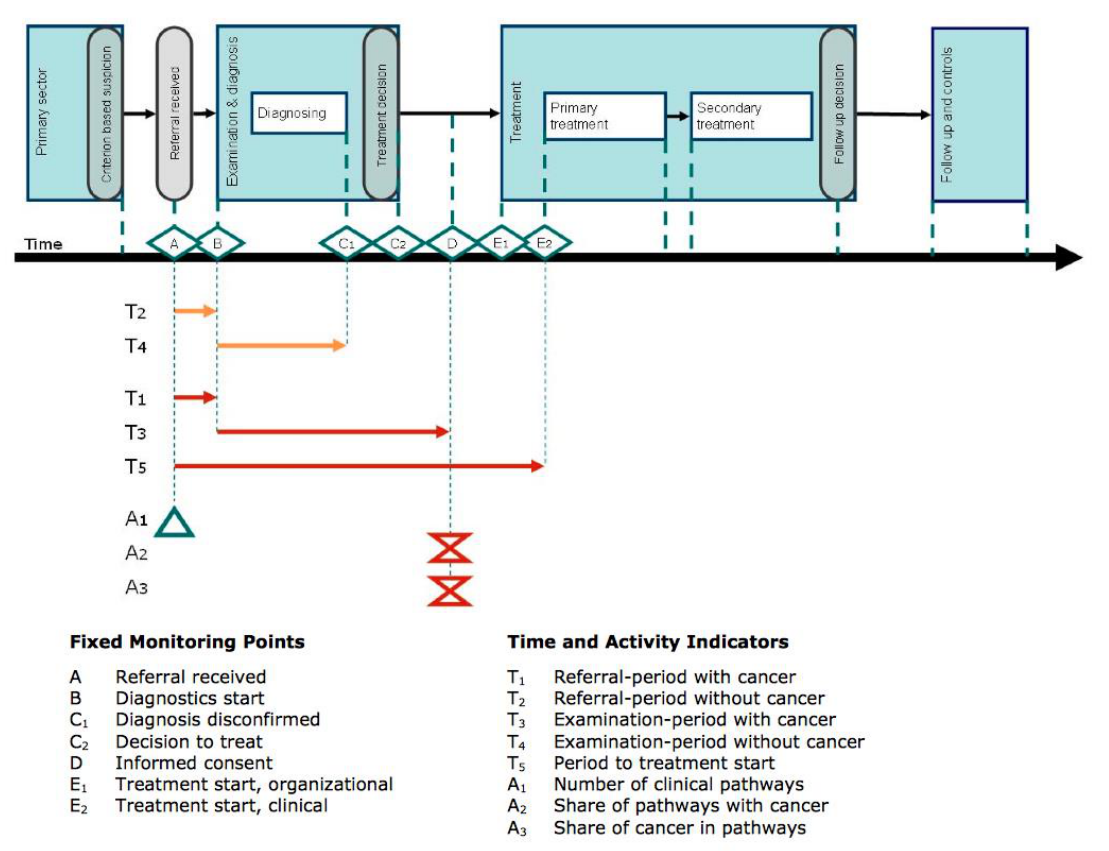
Figure 2: The monitoring model for integrated cancer